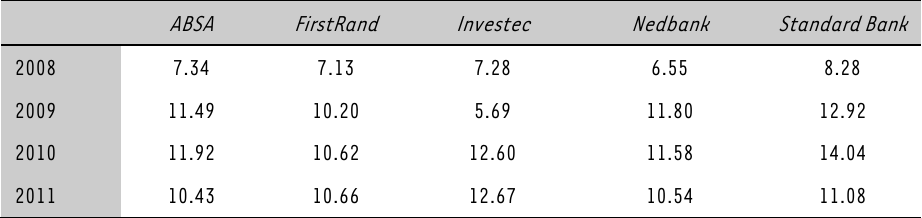
TABLE 10: Yearly P/E